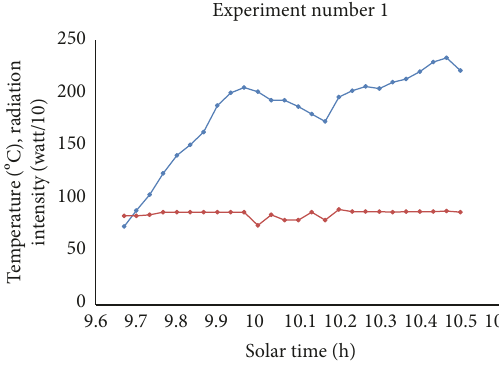
Figure 9: Plot of temperature (blue) and solar radiation intensity (red) versus time for the second unloaded experiment. Radiation intensity is divided by 10 to fi t the scale.